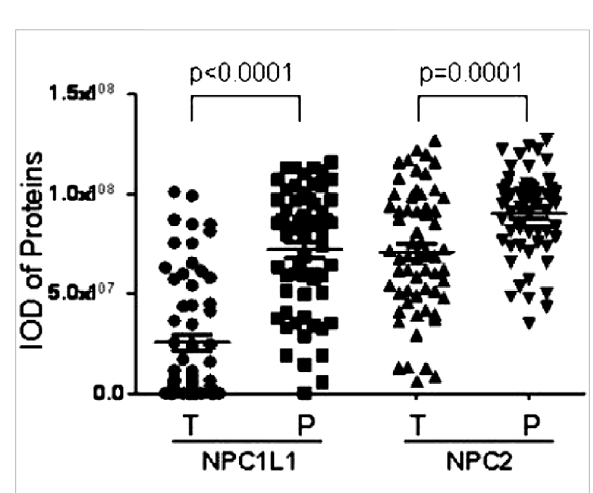
FIGURE 8 Scatter plot showing paired peritumor tissues shows that NPC1L1 and NPC2 expressions in HCC tumor tissues are usually lower than those in peritumor tissues (NPC1L1 p < 0.0001; NPC2 p = 0.0001) (Chen et al.,